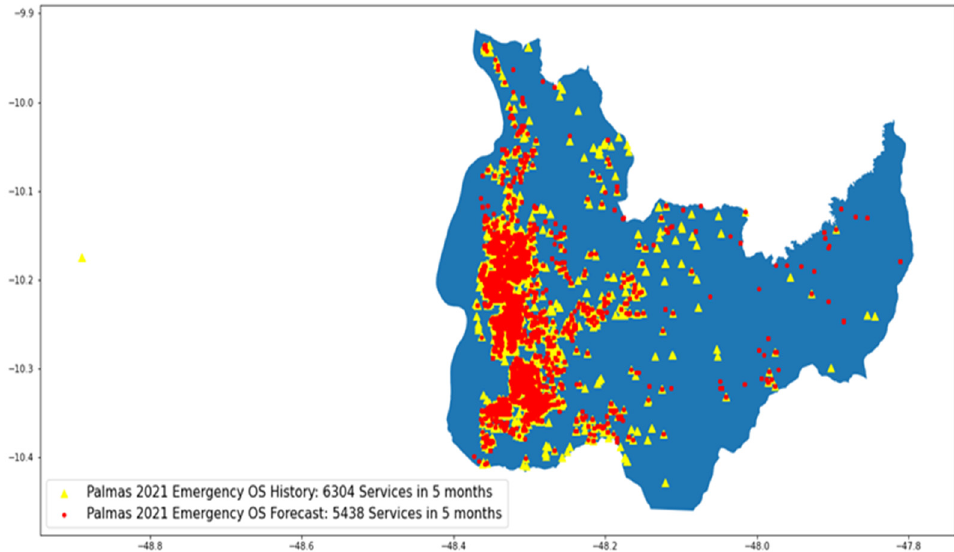
Figure 9. Spatial distribution of the predicted and executed emergency SOs throughout Palmas, in the state of the Tocantins in Brazil, for the first 5 months of 2021.